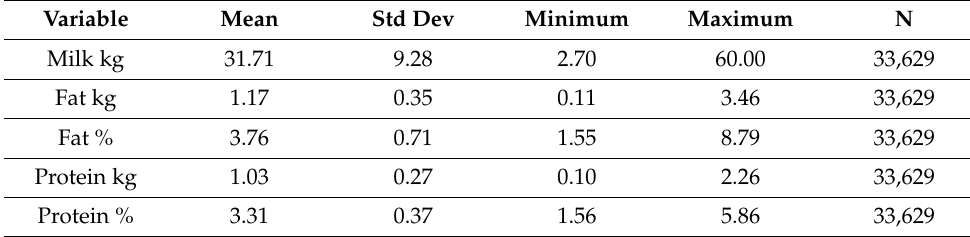
Table 6. Descriptive statistics for the milk variables (test day records).